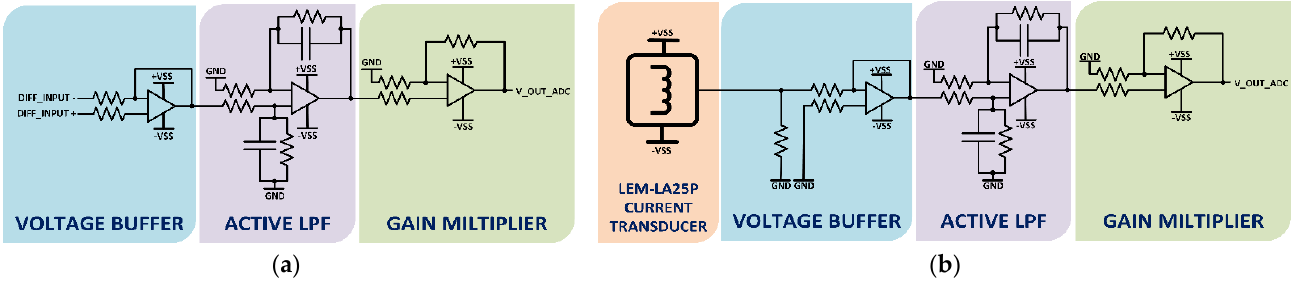
Figure 10. ( a ) Voltage measurement circuit. ( b ) Current measurement circuit.